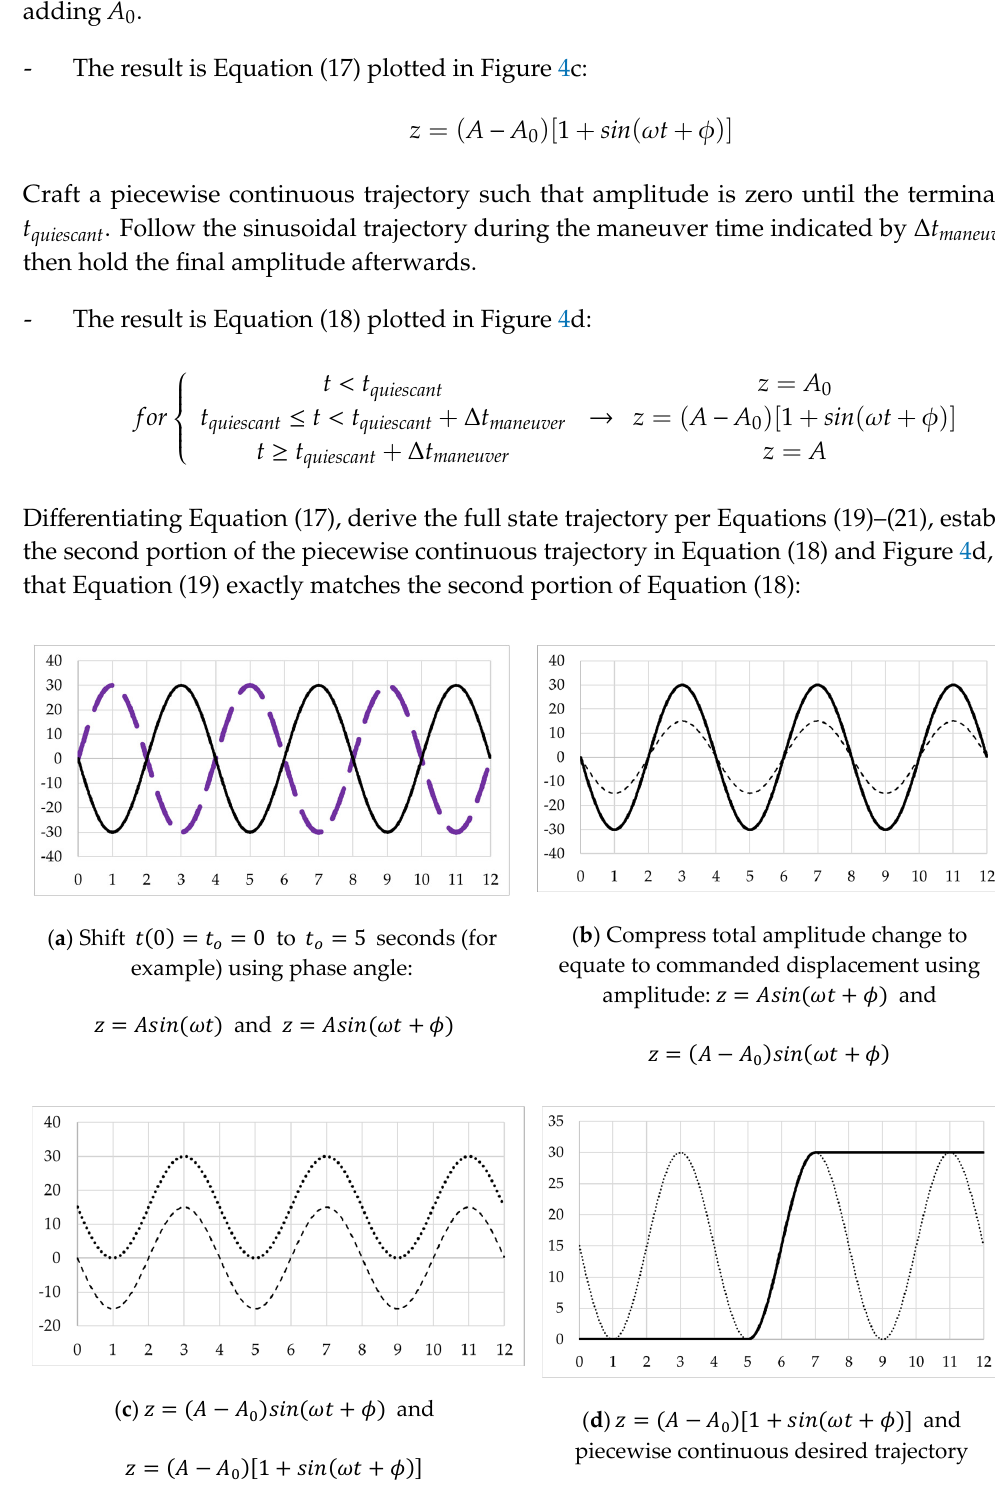
Figure 4. Creation of a piecewise-continuous sinusoidal maneuver trajectory autonomously generated to guarantee a specified maneuver time (to be provided by offline optimization).